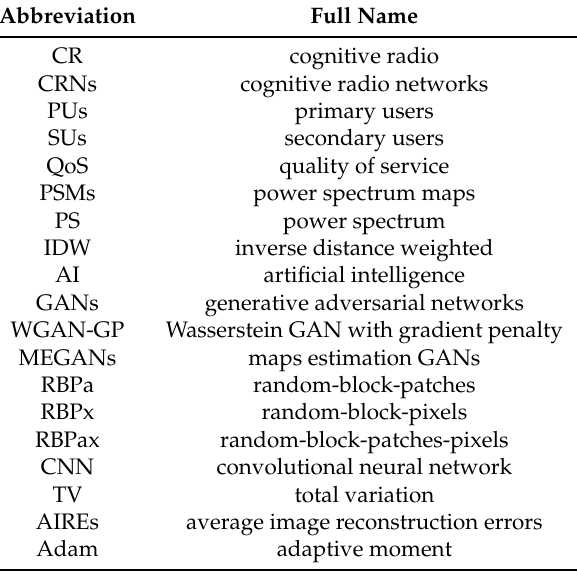
Table 1. The list of